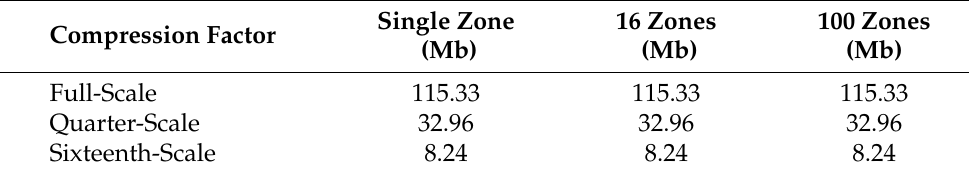
Table A4. Source identification